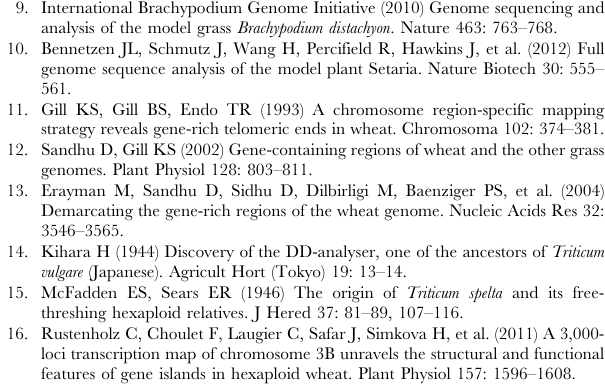
Table S1 Locations of genes in nine Ae. tauschii contigs, the distances between neighboring genes, and homology of intergenic regions to LTR retrotransposons. Table S2 Locations of genes in the rice regions ortho- logous to the Ae. tauschii contigs, the distances between neighboring rice genes, and homology of the intergenic regions to LTR retrotransposons. Table S3 Locations of genes in the B. distachyon regions orthologous to the Ae. tauschii contigs and the distances between neighboring B. distachyon genes. Table S4 Locations of genes in the S. bicolor regions orthologous to nine Ae. tauschii contigs and distances between neighboring S. bicolor genes. Table S5 Orthologous gene pairs and their intergenic distances in Ae. tauschii , rice, B. distachyon , sorghum, and maize. Table S6 Orthologous gene pairs in Ae. tauschii and rice, their intergenic distances and homology of the intergenic sequences to known